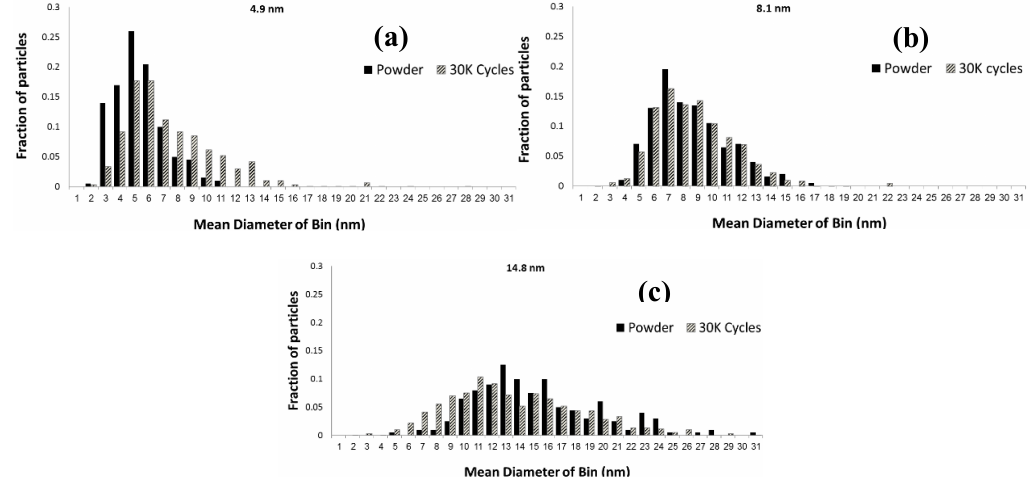
Figure 6. TEM analysis of Pt 3 Co particle size distribution of the pristine ( black ) and decayed MEAs ( hashed ), ( a ) 4.9 nm ( b ) 8.1 nm and ( c ) 14.8 nm Pt 3 Co supported on